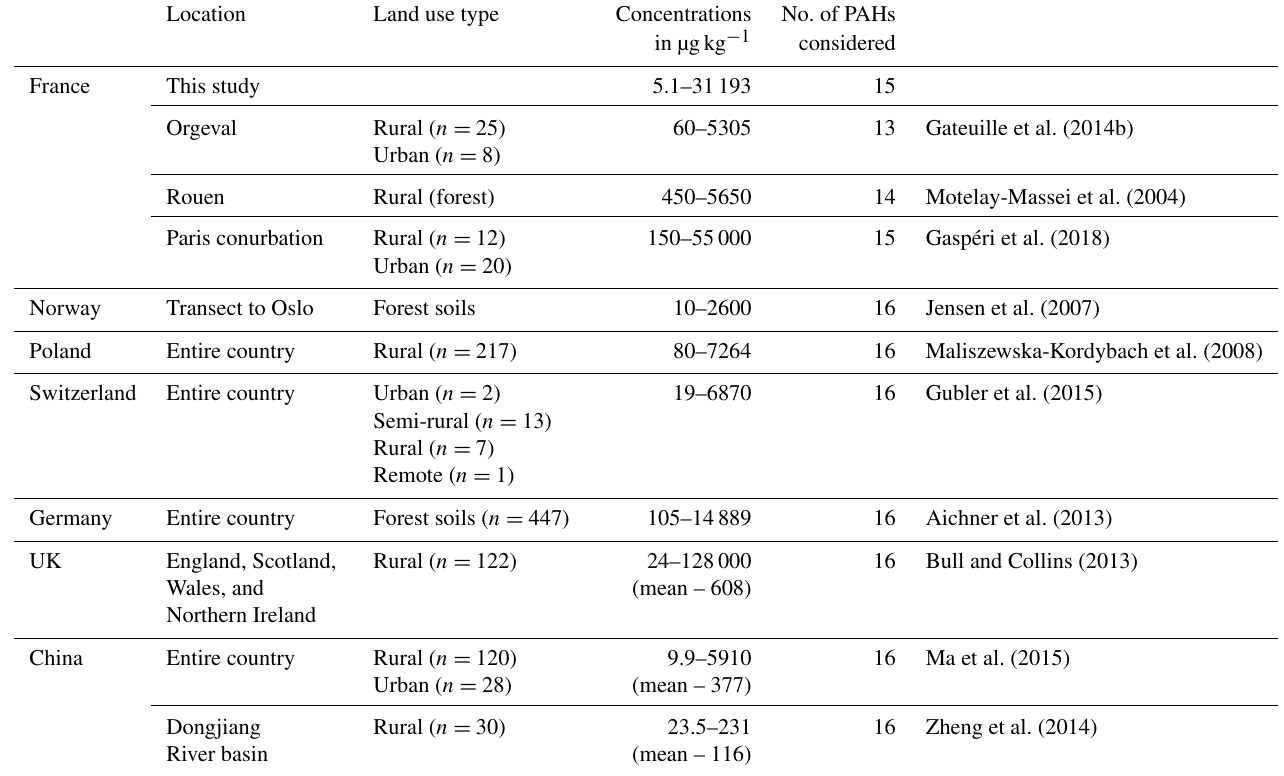
Table 4. PAH concentrations in soils reported in the literature in micrograms per